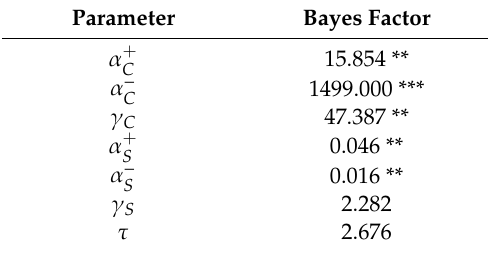
Table A6. Bayes factors for e ff ects of session on model